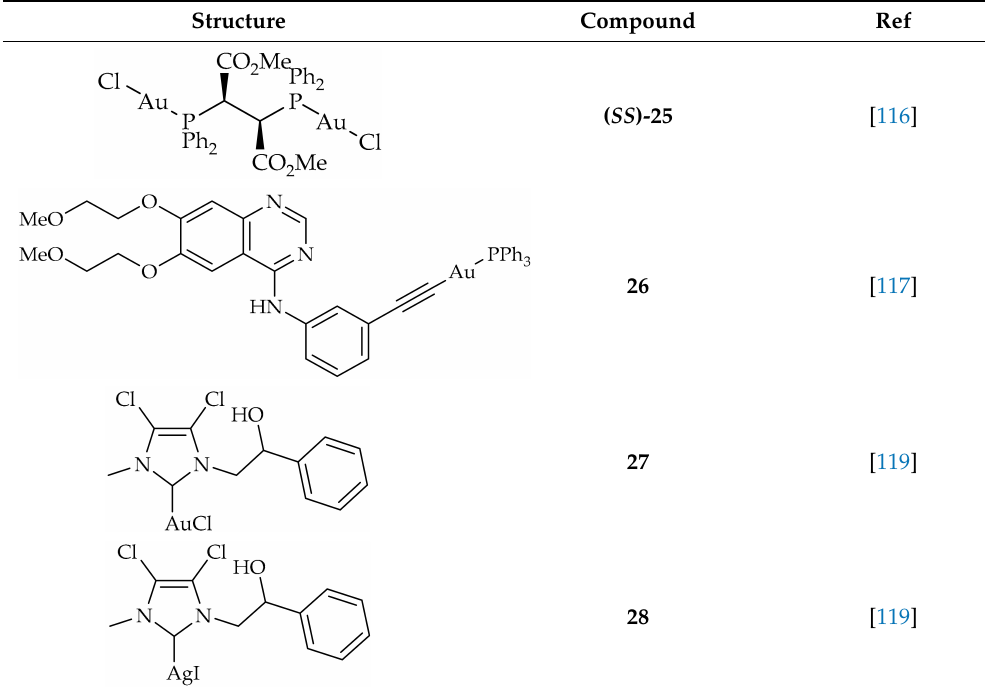
Table 4. Structure of metal complexes studied for the treatment of